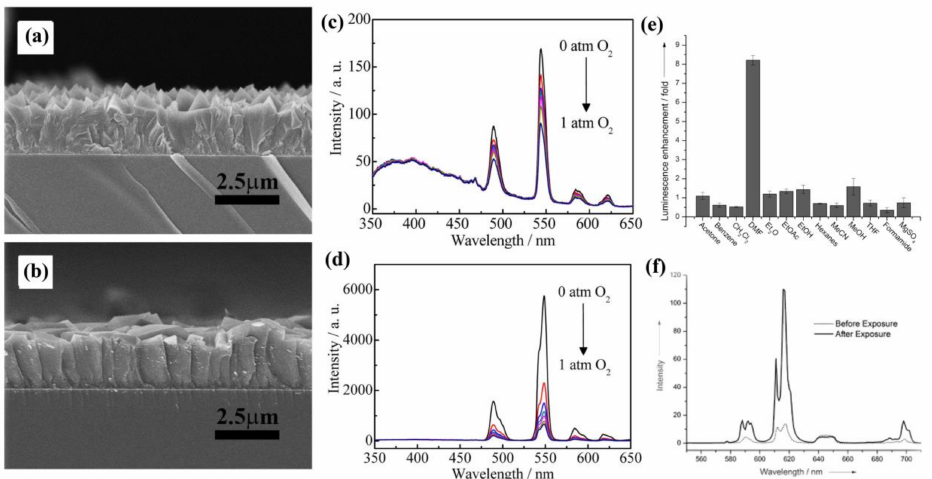
Figure 9. SEM images of CPM-5 ⊃ (cid:84) Tb 3+ ( a ) and MIL-100(In) ⊃ (cid:84) Tb 3+ ( b ) films. Emission spectra of activated ( c ) CPM-5 ⊃ (cid:84) Tb 3+ and ( d ) MIL-100(In) ⊃ (cid:84) Tb 3+ films under different oxygen partial pressure (Po 2 ). Reproduced with permission from [109]. Copyright 2014 American Chemical